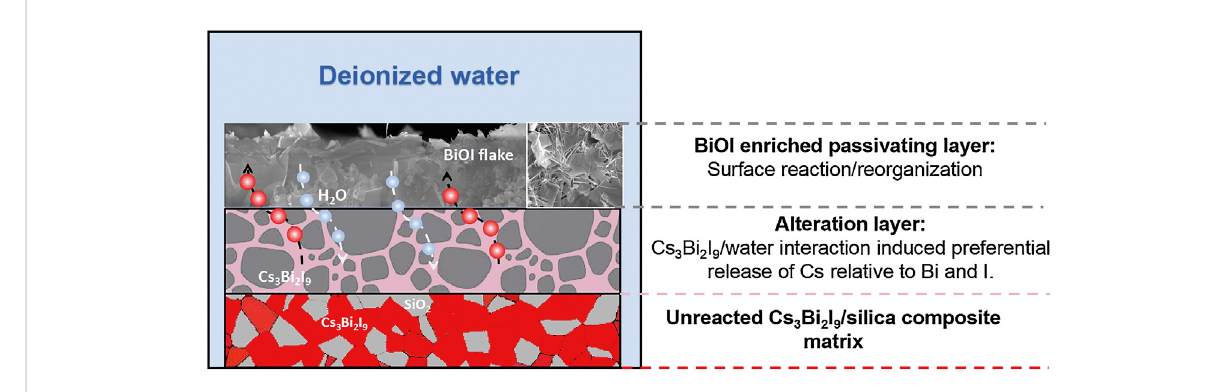
FIGURE 10 Schematic of durability mechanism for Cs 3 Bi 2 I 9 silica composite (K. Yang et al.,